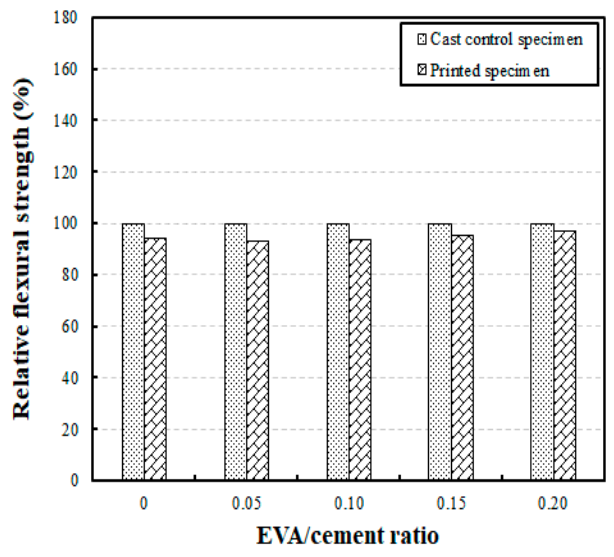
Figure 11. Comparison of relative flexural strengths of cast and printed specimens for different EVA/cement ratios.